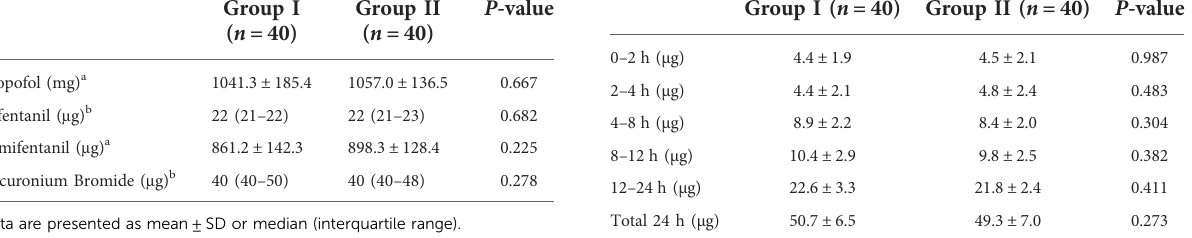
TABLE 4 Comparison of anesthetics consumption dosage between the two groups during the maintenance of